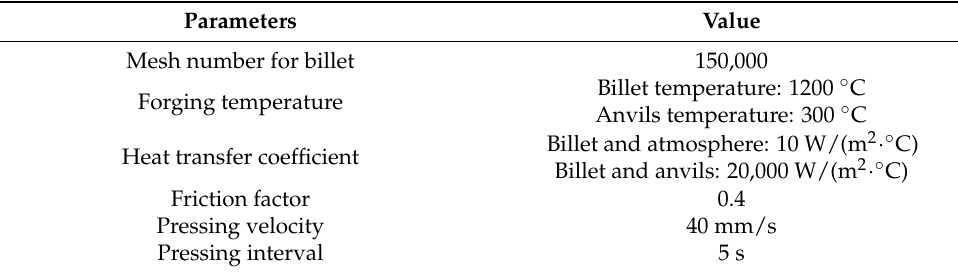
Table 2. Numerical simulation